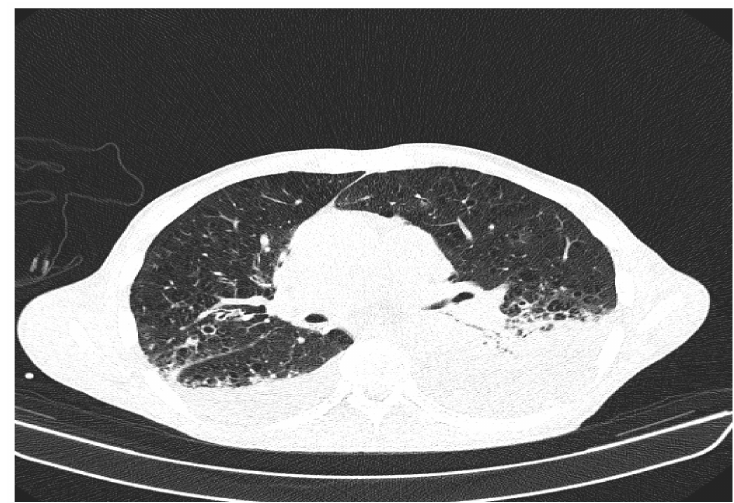
Figure 5. Patient’s computer tomography: bilateral posterior-basal pleurisy.